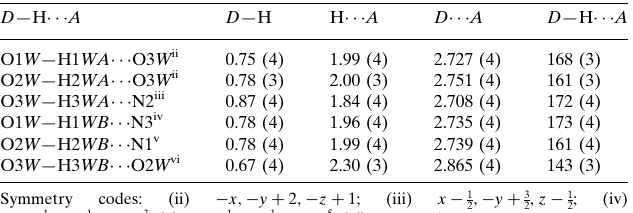
Hydrogen-bond geometry (A˚ , (cid:2)